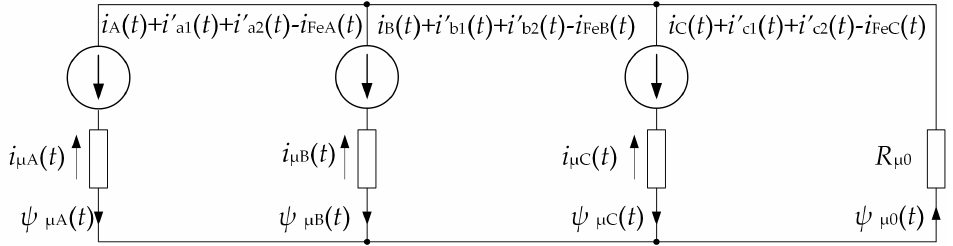
Figure 16. Schematic diagram of the magnetic circuit of the modeled